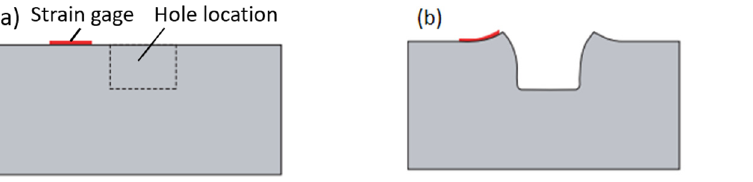
Figure 3. Schematic cross-sections around a hole drilled into tensile RS [19] ( a ) before and ( b ) after hole drilling ( c ) strain gage arrangement direction.